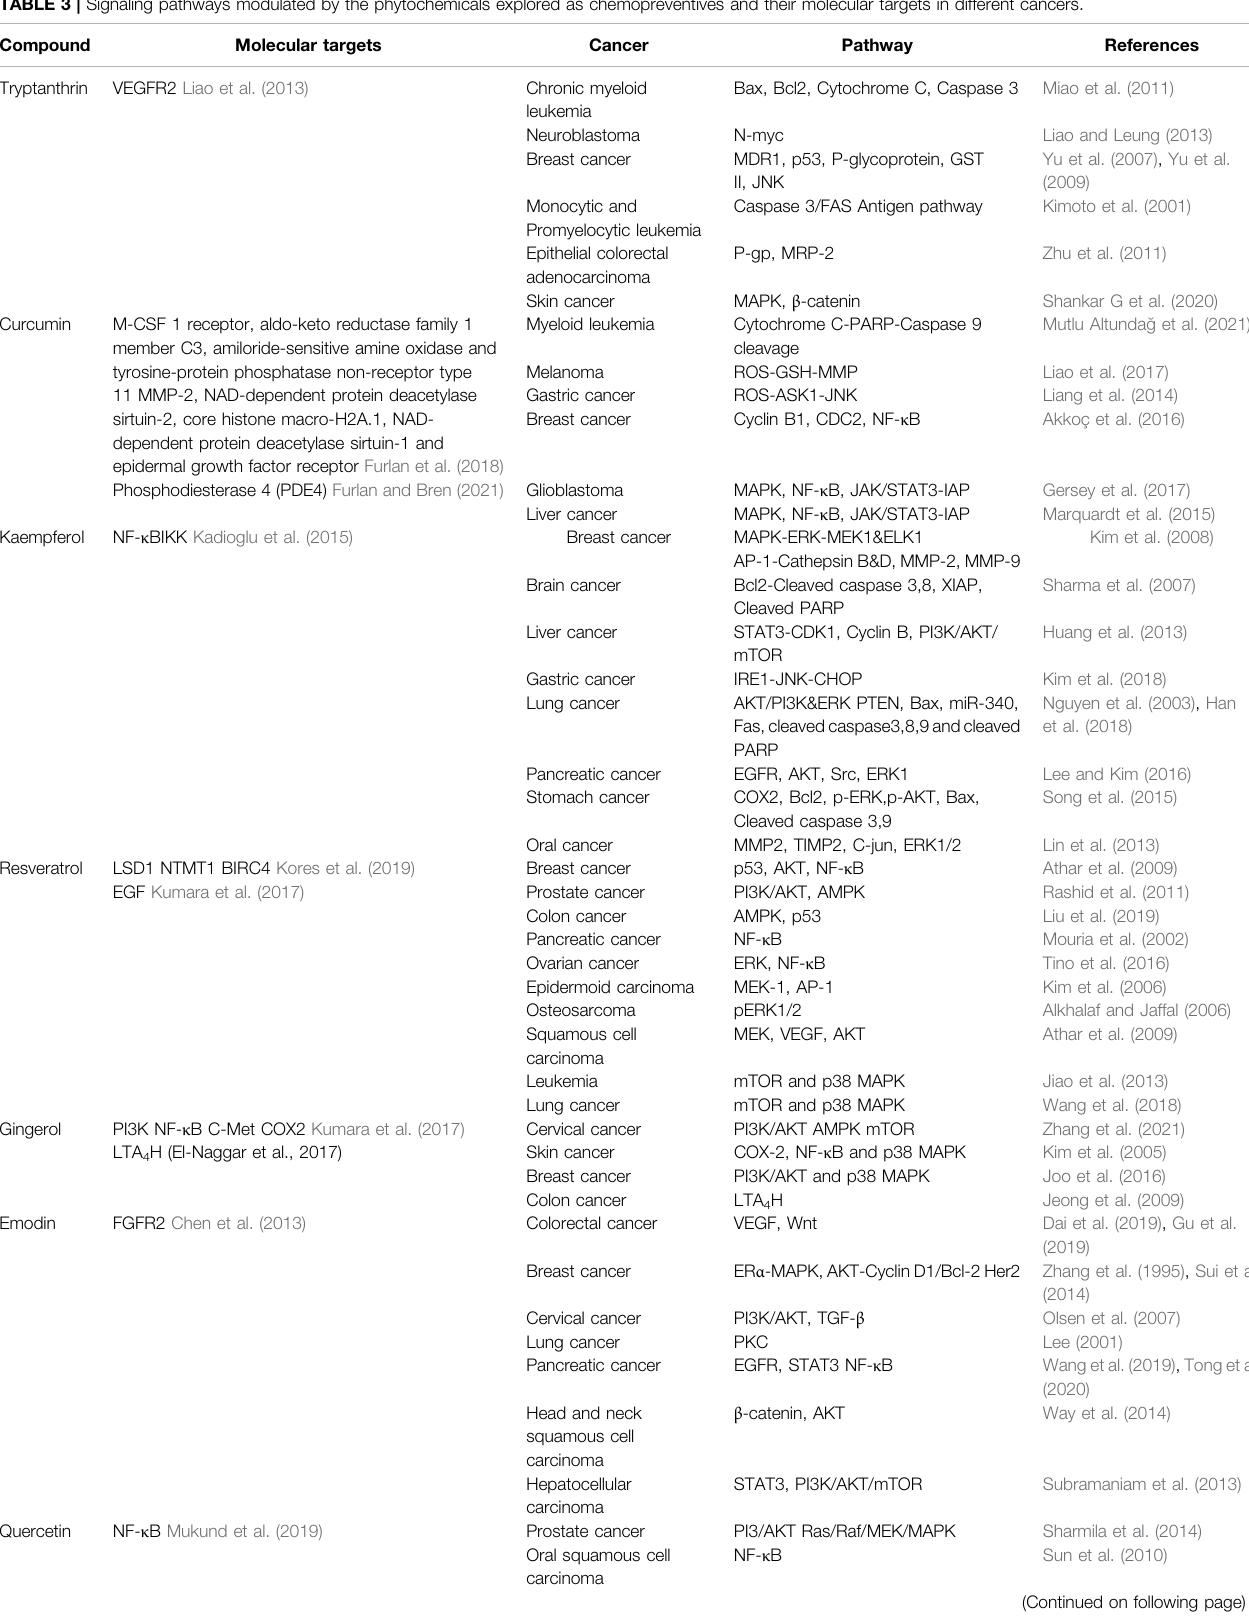
TABLE 3 | Signaling pathways modulated by the phytochemicals explored as chemopreventives and their molecular targets in different cancers.